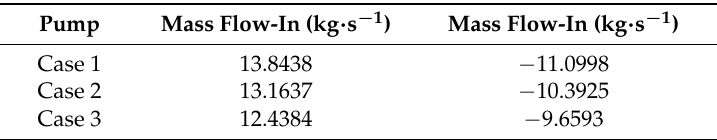
Table 4. Exchanged mass